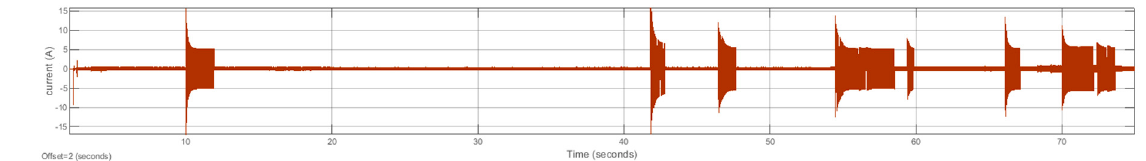
Figure 8. Digital flickermeter [28] output for the simulation of the Matlab Simulink model shown in Figure 7.